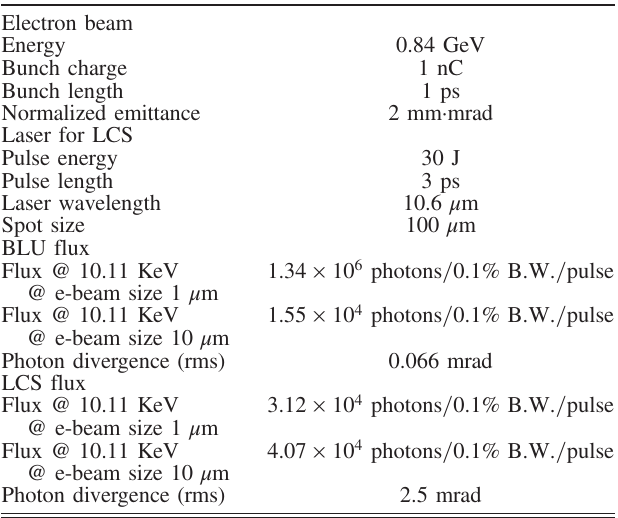
TABLE II. Flux comparing between BLU and